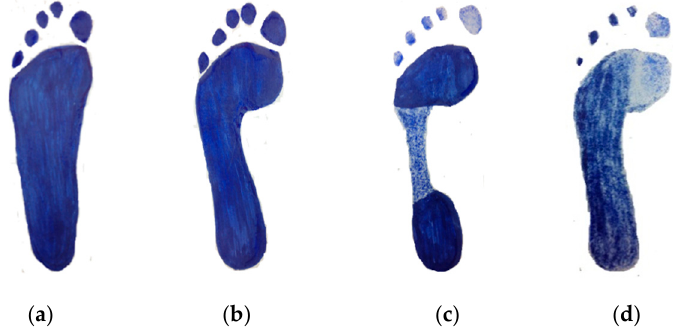
Figure 1. Schematic illustration of foot pressure distribution of ( a ) flat foot; ( b ) neutral foot; ( c ) cavus foot; and ( d ) supinated foot of left footprint when standing.